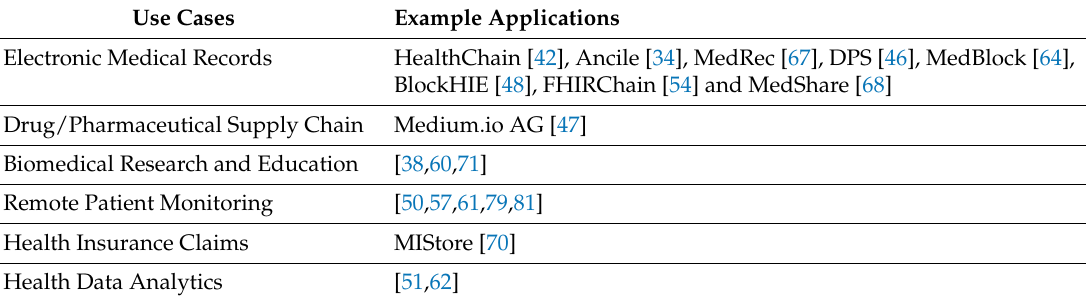
Figure 11. Publication size per paper type per year. Table 5. Use cases and example applications.